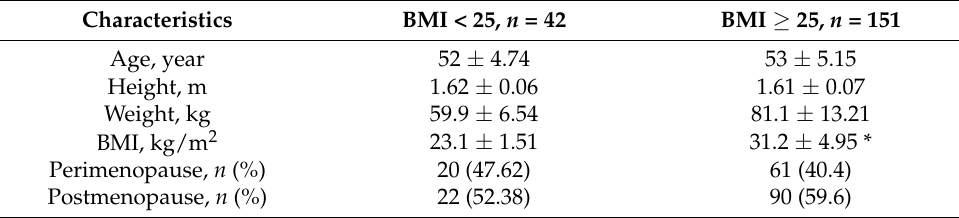
Table 1. Profile of women with different body mass index